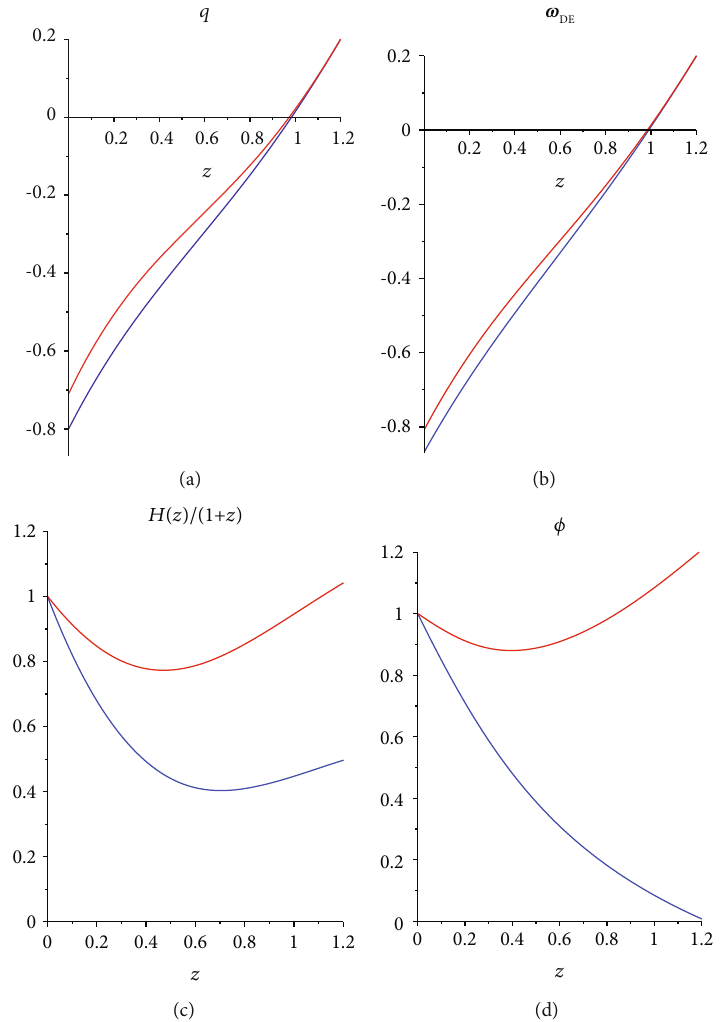
β = 23 : 5 , with α = 0 : 06 and η = 0 : 04 (blue DE (25) (b) for